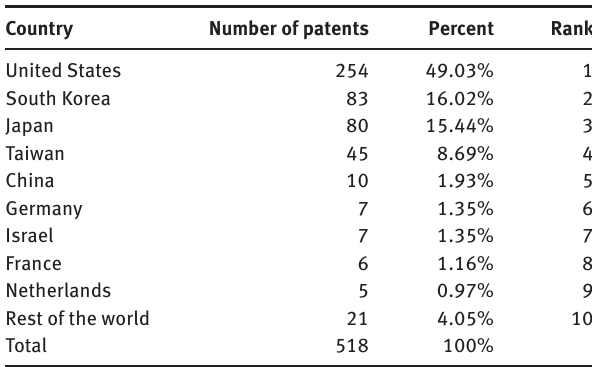
Table 1: The ranking of countries based on their share of